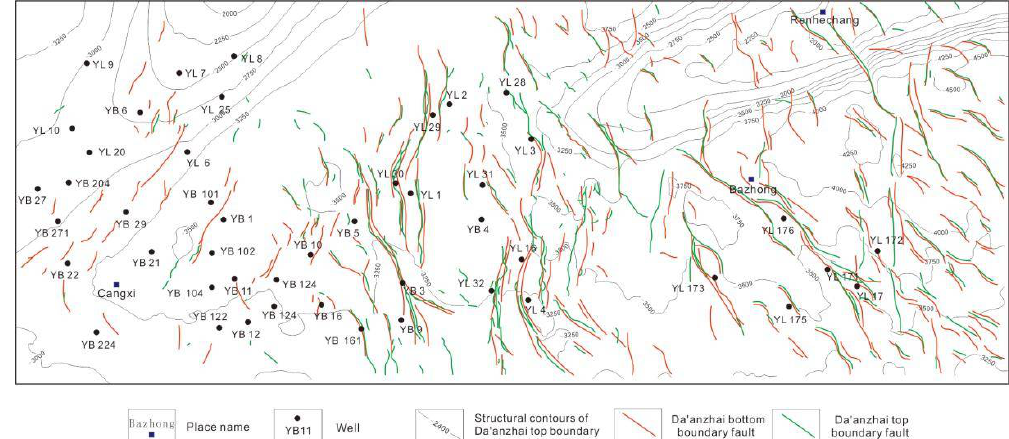
Figure 14. Distribution map of the top boundary and bottom boundary of the Da’anzhai section in Yuanba area.